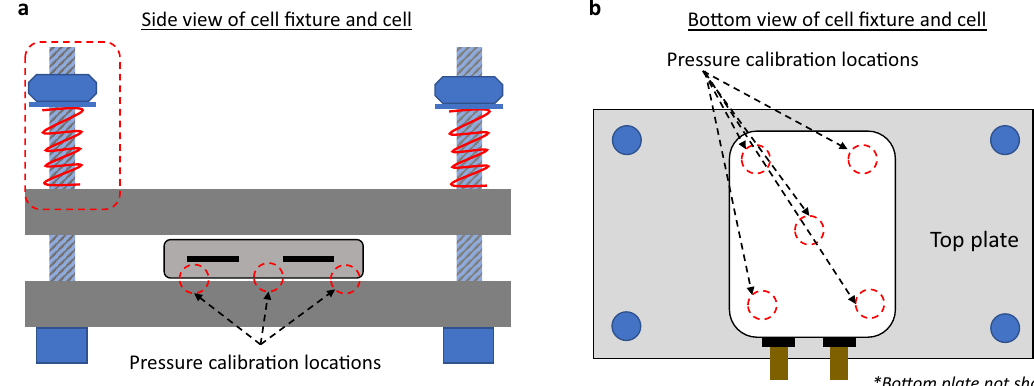
Fig. 4 Illustration of suggested multi-point pressure calibration position for common two-plate cell fi xture design. a cross-section side view of the cell fi xture and cell, with suggested calibration locations showed in red circles; b bottom view of the cell fi xture and cell (bottom plate not shown for clear view) with suggested calibration locations showed in red